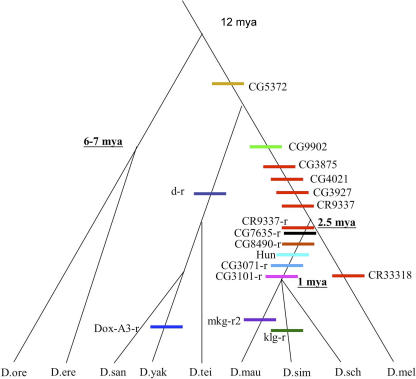
The Phylogenetic Distribution of the 17 New DLR Duplicates Identified in This StudyThe species phylogeny and time scale are from [58]. Different color bars show different gene families. The kep1 gene family has six new duplicates (indicated by red bars).